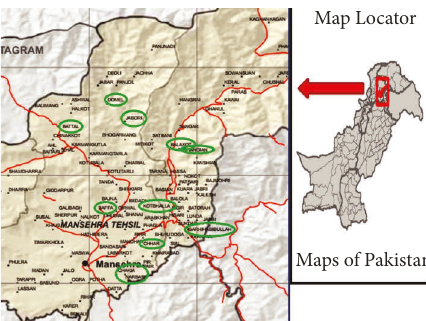
Figure 1: Map of district Mansehra from where genus ( Fragaria ) species were collected and the areas of Mansehra included Jabori, Garhi Habibullah, Baffa, Kund Bangla, Shogran, Batal, Balakot, Dodial, Chattar, and Qalandarabad. Table 1: GPS location of different regions of Mansehra, Pakistan.